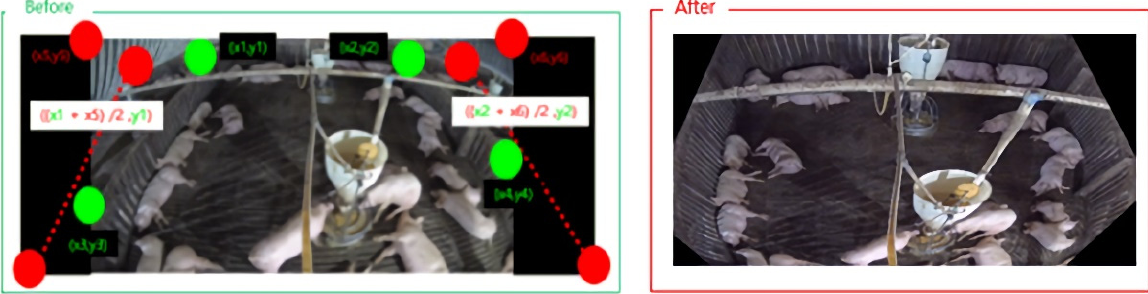
Figure 3. Image of original image and perspective transformation applied image. Left image represents input image filmed from surveillance camera with line to apply perspective transformation on. Right image represents aftermath of perspective transformation method.